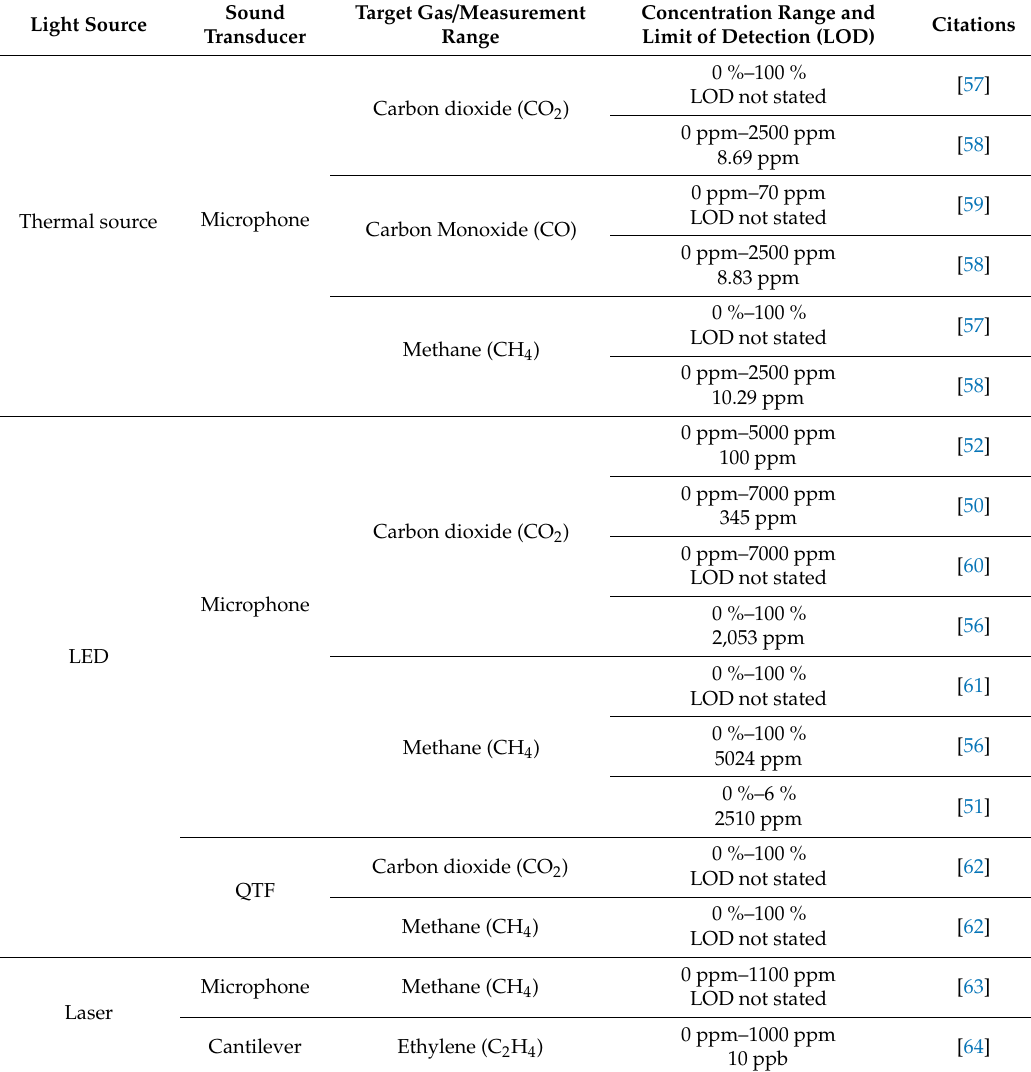
Table 1. Photoacoustic NDIR demonstrations. Both the concentration range as well as the limit of detection are stated for ambient pressures of 1 bar. The values are stated either in part-per-million (ppm), parts-per-billion (ppb), or percent (%), whichever is most